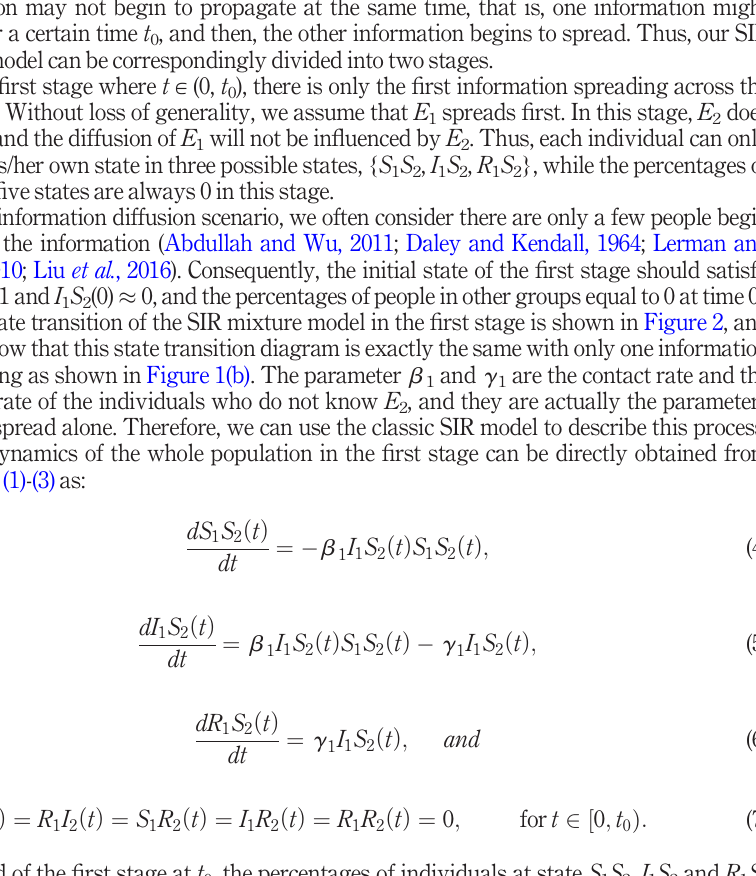
Figure 2. The state transition of the SIR mixture model in the fi rst